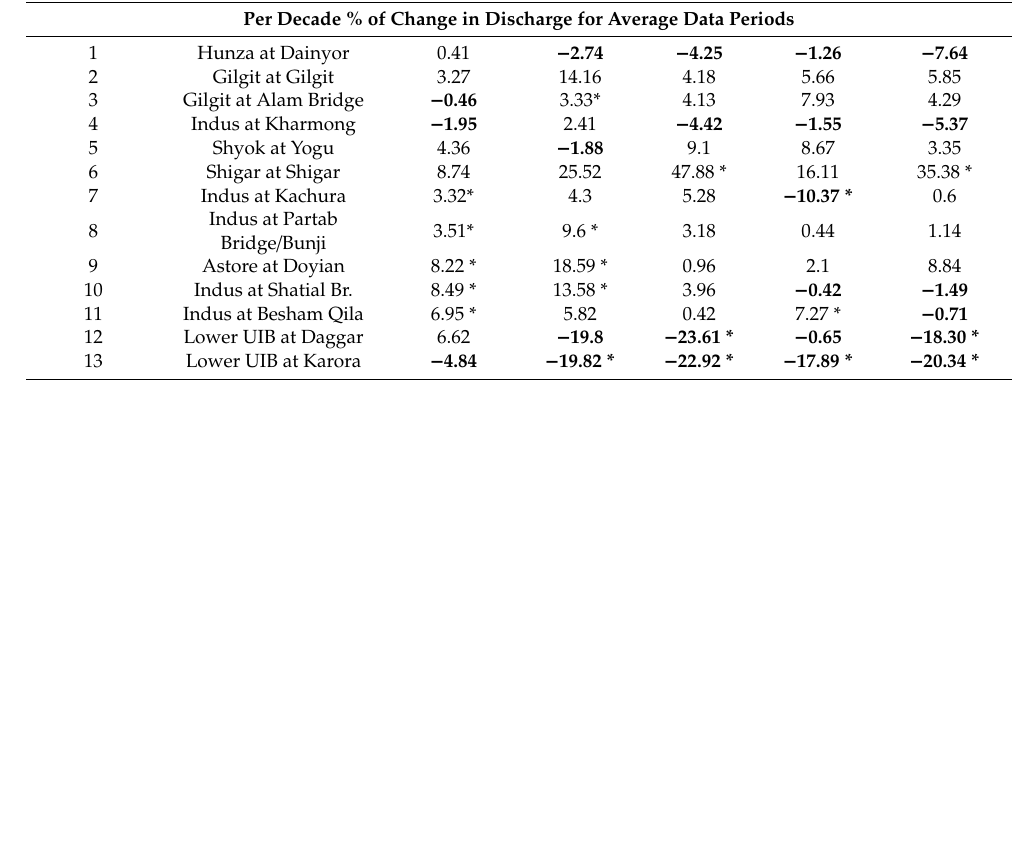
Table 7. Annual and seasonal percentage changes per decade for mean of data periods. Discharge Gauging Sr # DJF Stations